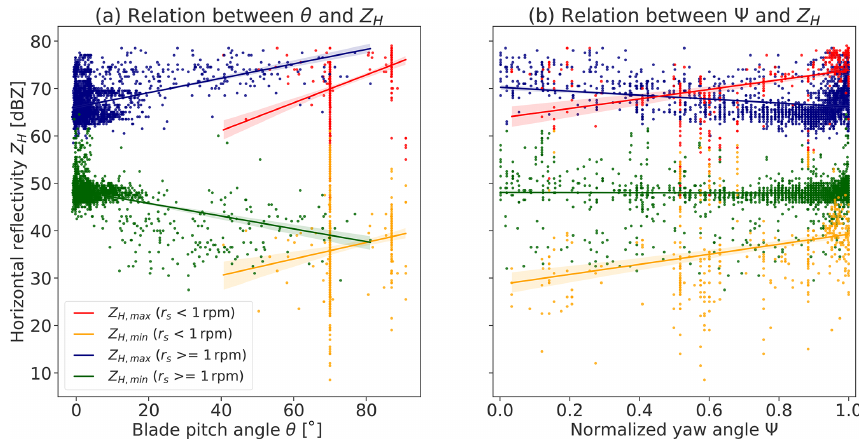
Figure 14. Scatterplots and corresponding linear regression lines with confidence interval sizes of 95% for the regression estimate (translu- cent bands) showing the relations between the blade pitch angle θ (a) and normalized nacelle orientation (cid:57) (b) , respectively, and different sub-data sets of Z H . In particular the data sets Z H , max (blue and red) and Z H , min (orange and green) are each separated for the WT1 rotor speed threshold of 1rpm. The confidence intervals are estimated using a bootstrap method.